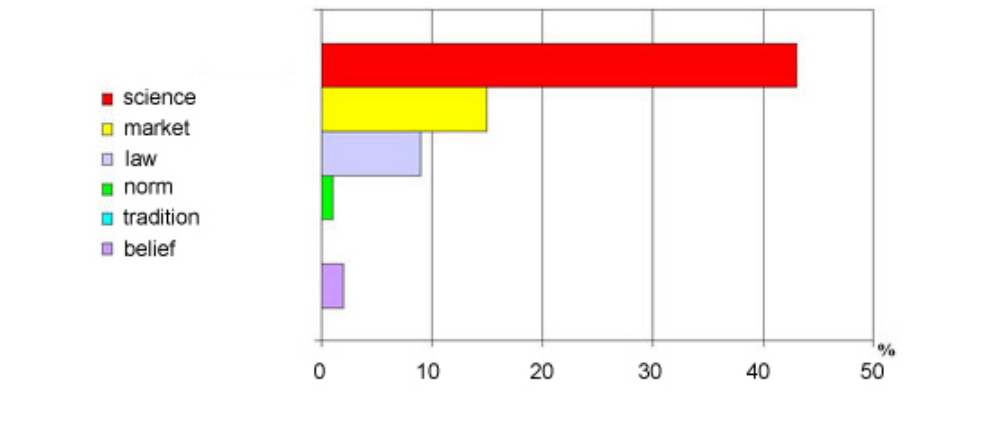
Fig. 1 . Frequency of justification domains used by workshop participants to justify their selection of key processes that drive changes in the Crocodile